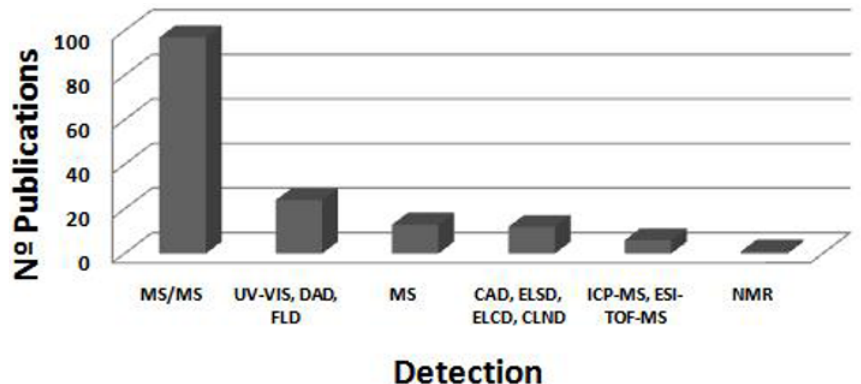
Figure 4. Detection techniques employed in HILIC pharmaceutical